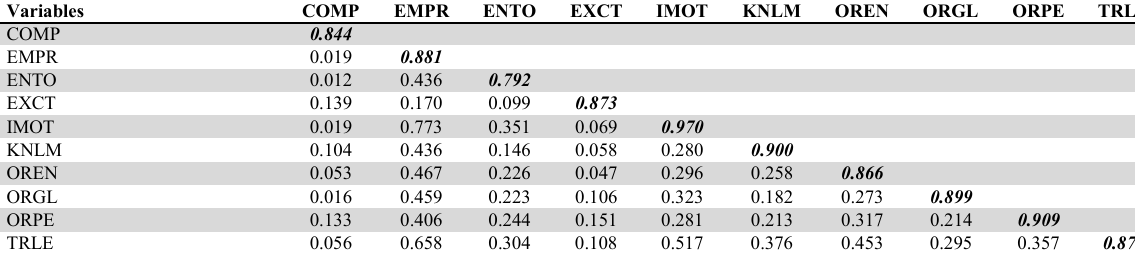
Discriminant validity using Fornell and Larcker’s criterion Variables